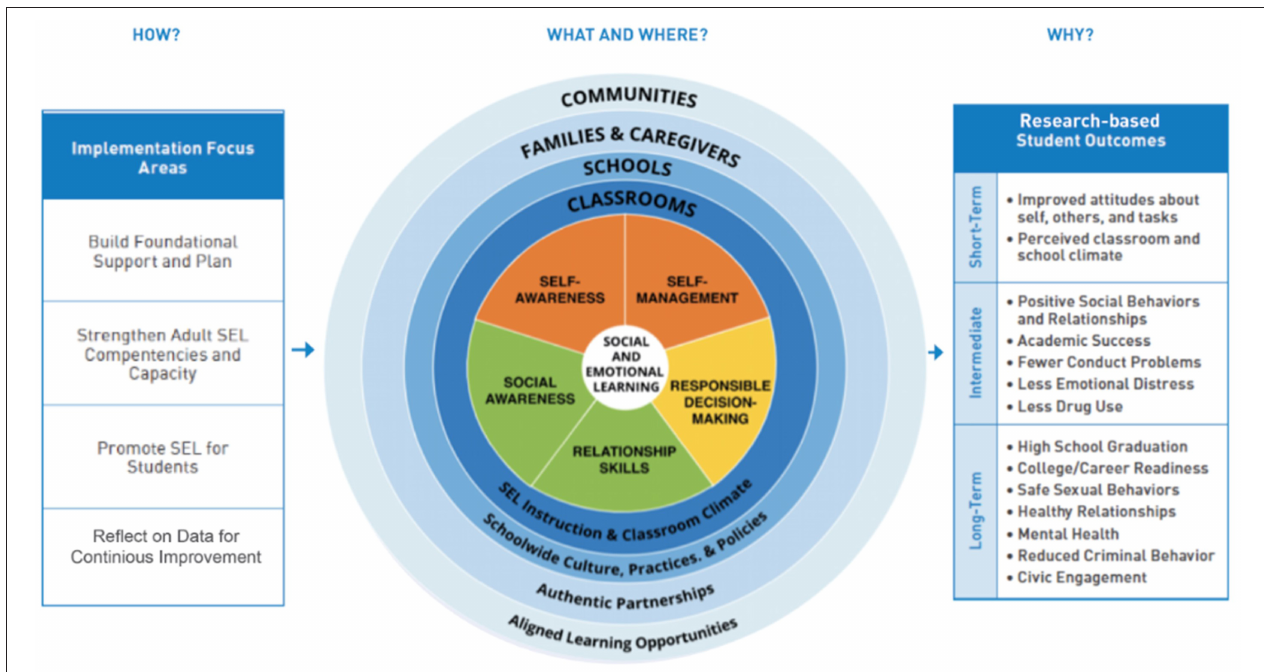
FIGURE 1 | CASEL Framework for Systemic SEL (Collaborative for Academic, Social and Emotional Learning,